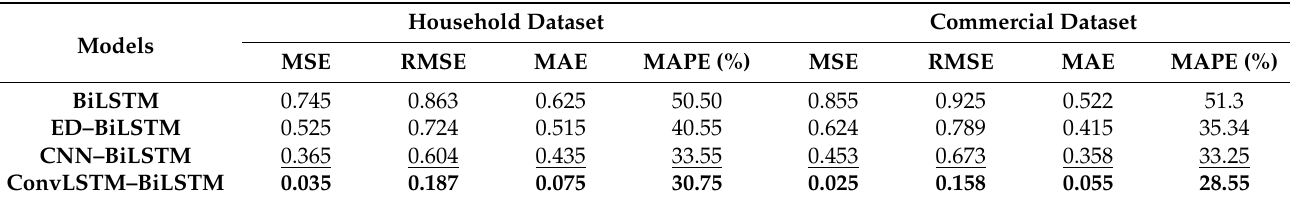
Table 3. Performance of the proposed models on the minutely